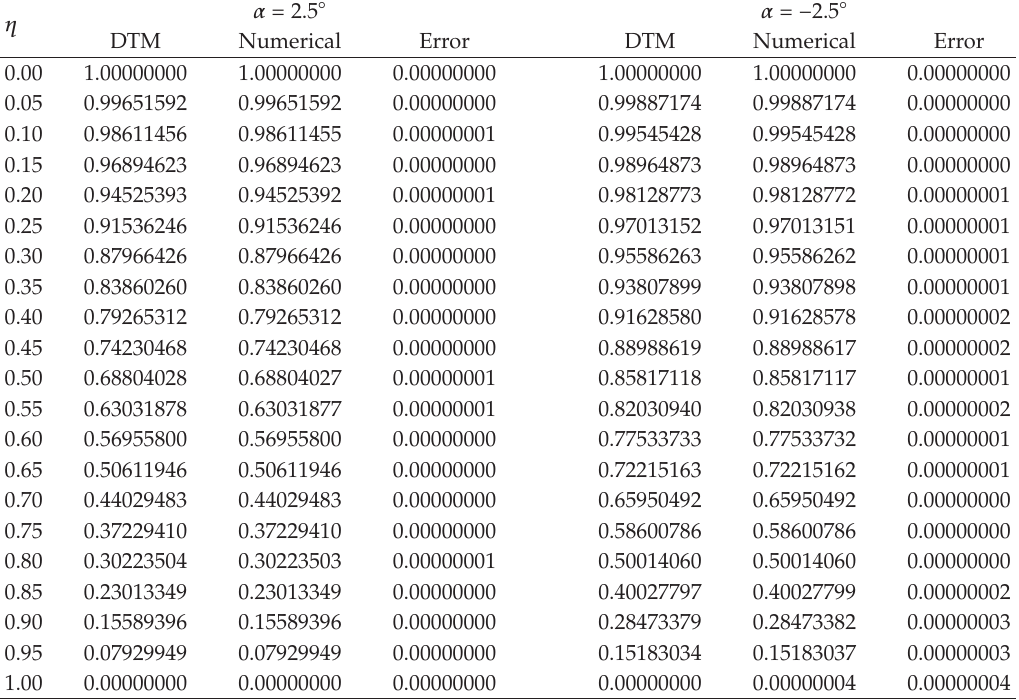
Table 1: The comparison between the numerical results and DTM solution for velocity when Re (cid:8) 100 and H (cid:8) 1500. α (cid:8) 2 . 5 ◦ α (cid:8) − 2 . 5 η